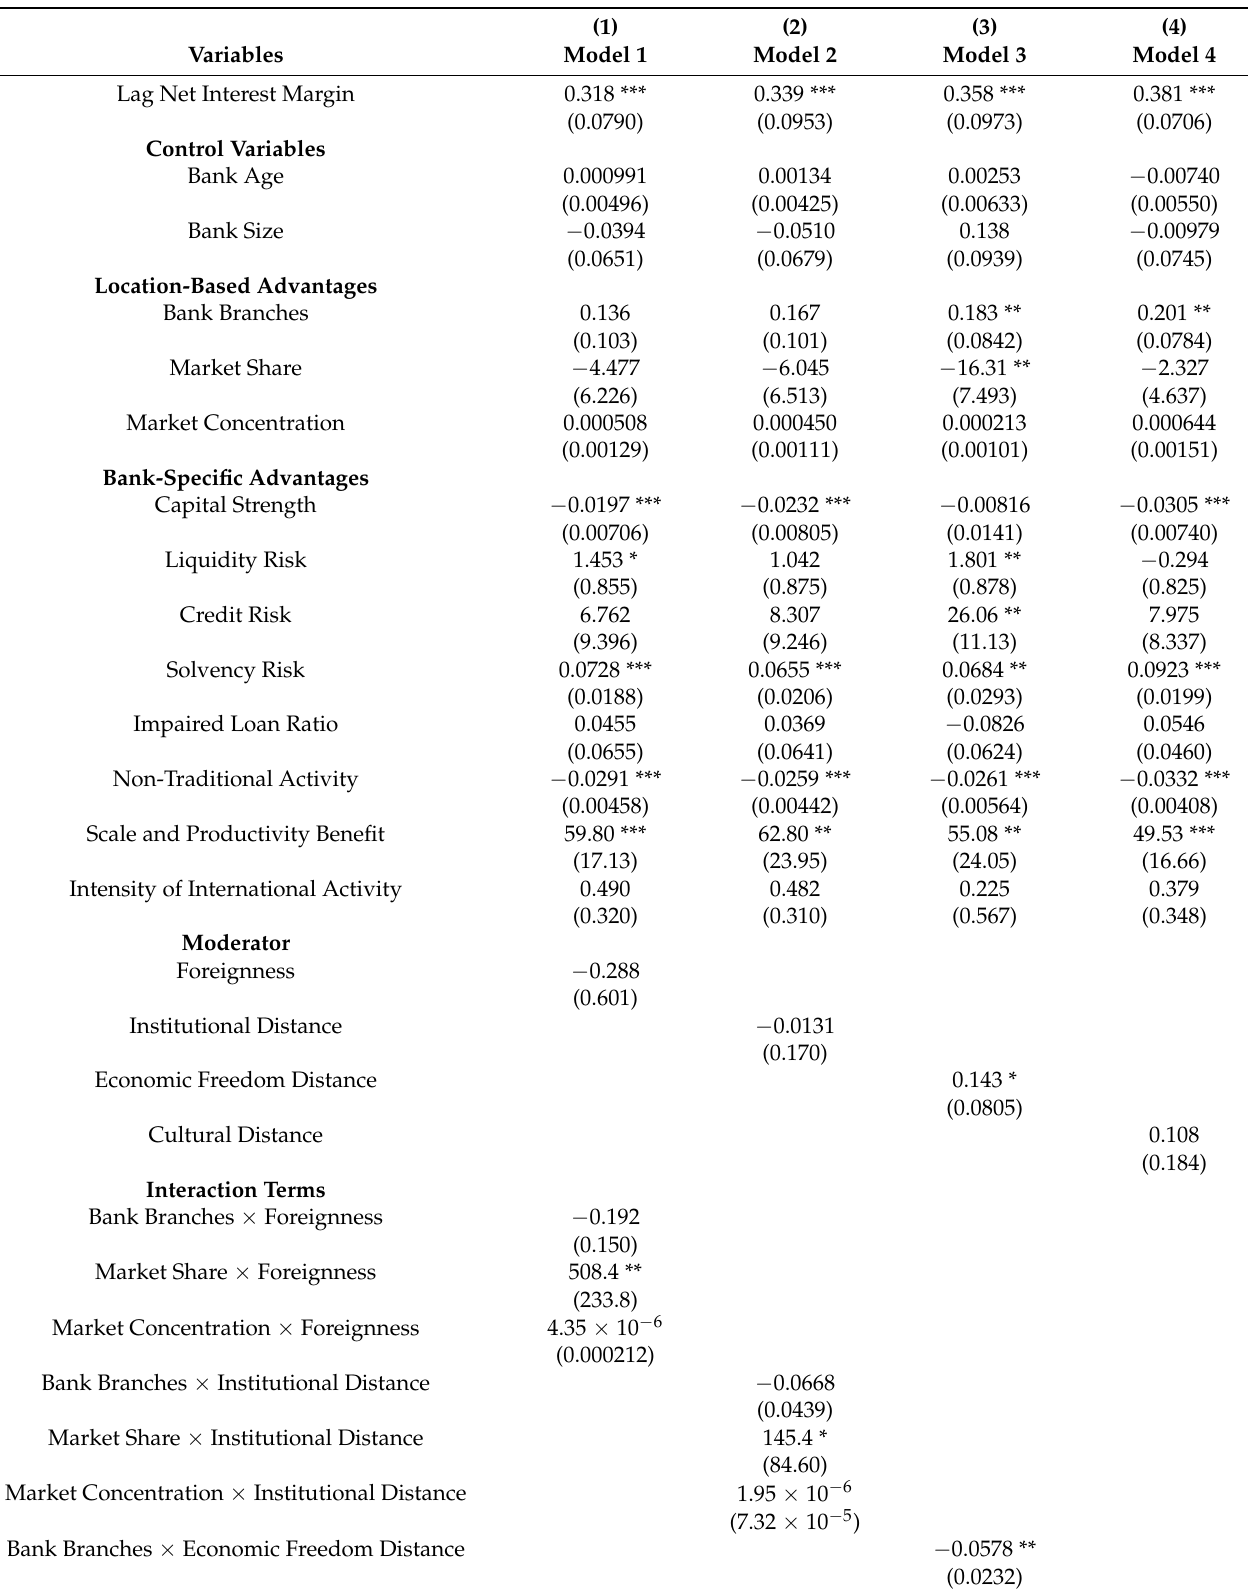
Table 11. Model of comparing dynamic cost of foreign liability with location-specific advantages (H4) in period: